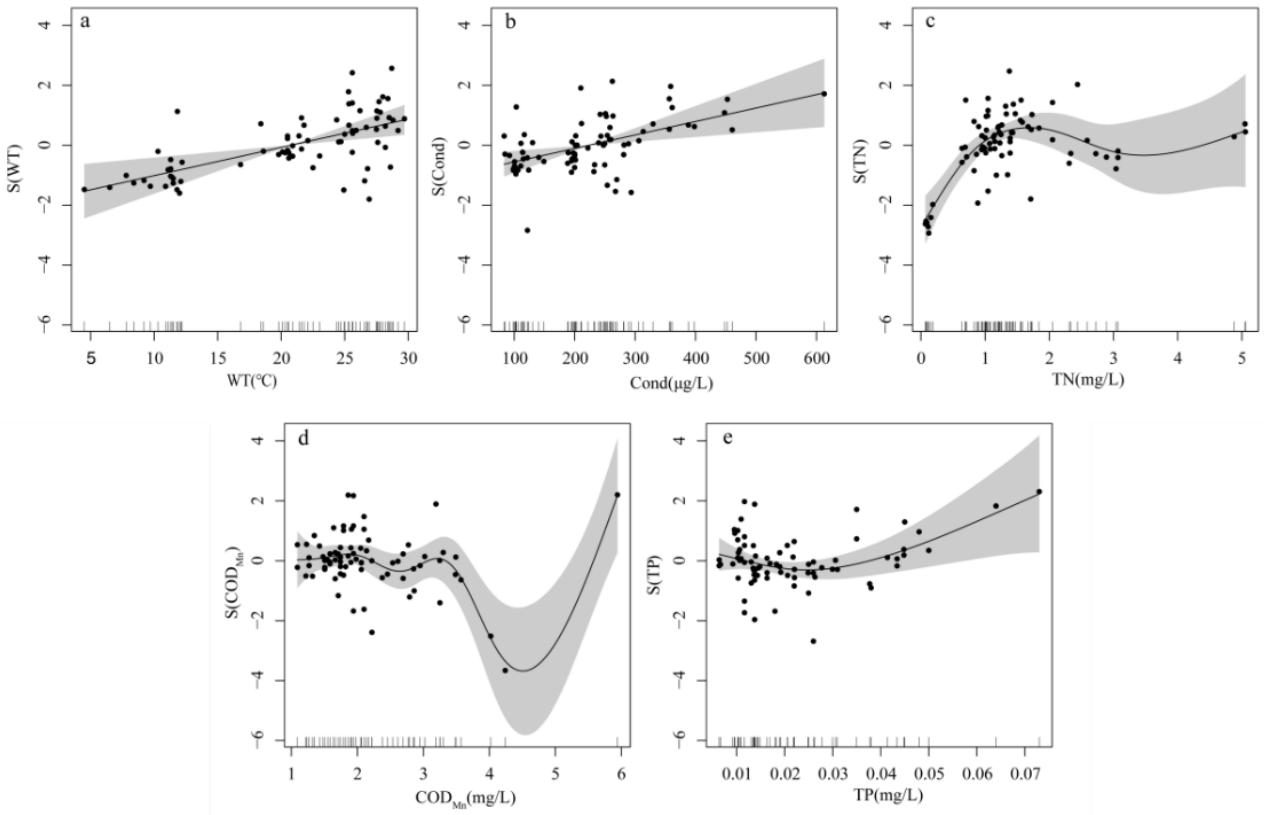
Figure 7. Effect of major environmental factors on the change of TOC concentration in the Dan- jiangkou Reservoir: ( a ) WT, ( b ) Cond, ( c ) TN, ( d ) COD Mn , ( e ) TP. The solid line in the figure indi- cates the smoothed fit of the explanatory variables to TOC concentration, the shaded area indicates the point-by-point standard deviation of the fitted additivity function (that is, the upper and lower limits of the confidence interval), the horizontal coordinates indicate the observed values of the explanatory variables, and the vertical coordinates indicate the smoothed fit of the explanatory variables to TOC concentration.